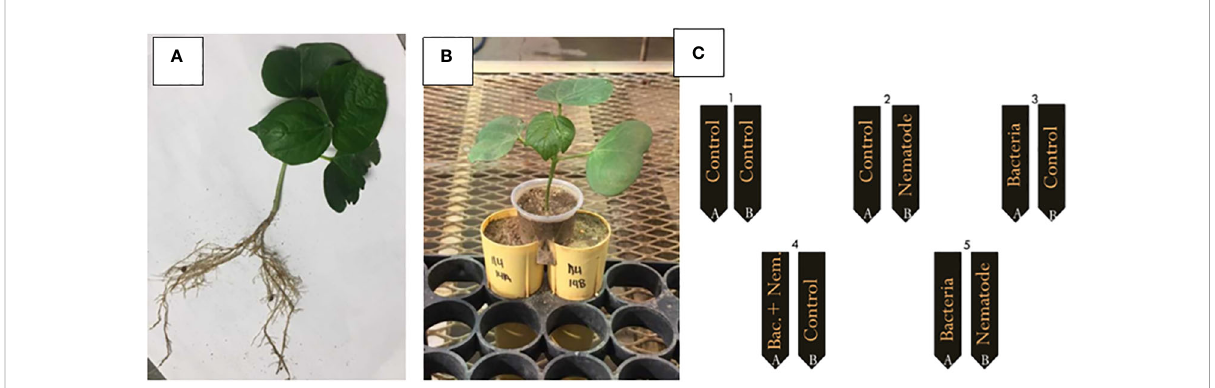
FIGURE 1 Example of a split root system; (A) two equivalent cotton root systems before planting in the split root set up, (B) after planting the cotton in the split root set up, and (C) inoculation pattern for the split root assay with 1) a control on root half A and B (control), 2) bacteria or fl uopyram inoculated on root half A and control on root half B (bacteria control), 3) control on root half A and Meloidogyne incognita eggs inoculated on root half B (nematode control), 4) bacteria or fl uopyram and M. incognita eggs inoculated on root half A and control on root half B, and 5) bacteria or fl uopyram inoculated on root half A and M. incognita eggs inoculated on root